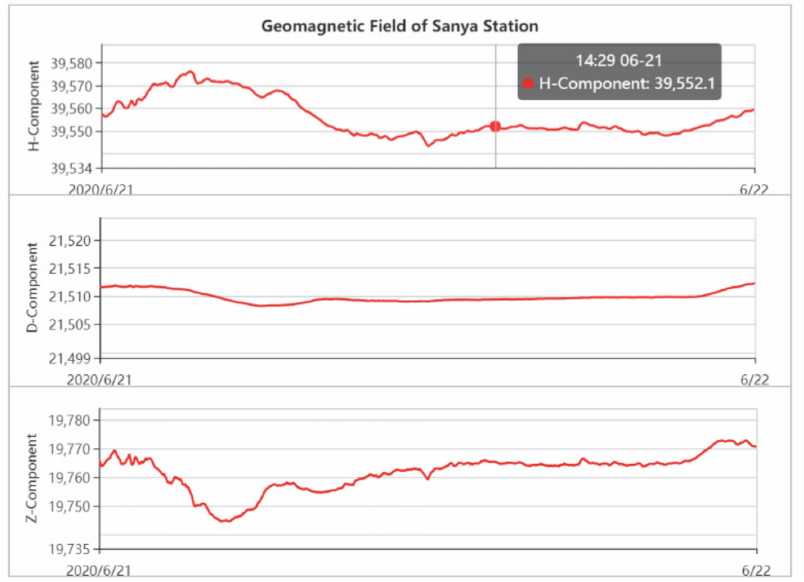
Figure 14. Geomagnetic field data of Sanya collected on 21 June 2020 (source: http://www.sepc.ac. cn/cosmicRays1.php (accessed on 6 February